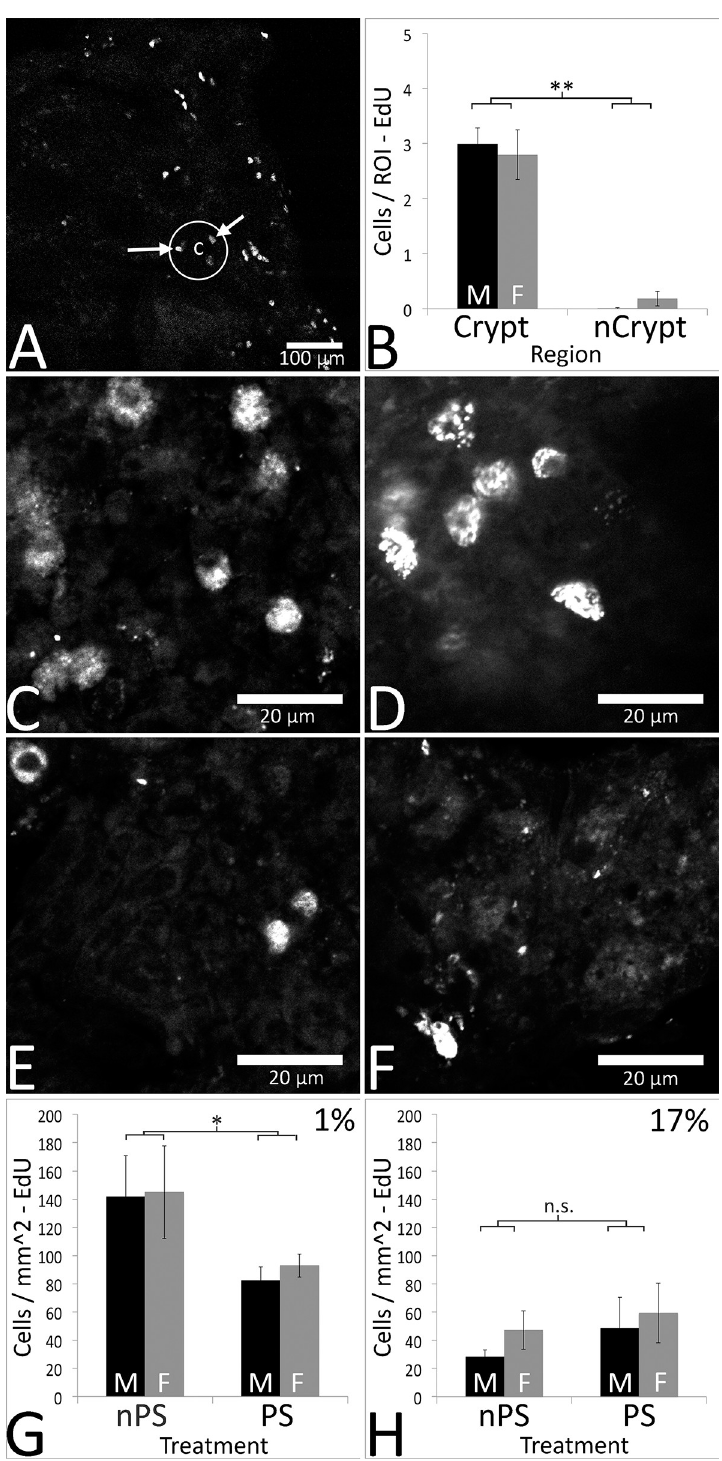
Fig 6. Incorporation of Ethynyl deoxyuridine (EdU) as indicative of DNA synthesis was observed in all oxygen and +/- PS treatments and across all time points (0 – 72h ex vivo). EdU was localized to cells in the colonic crypts (A). This localization was quantified (B), with significantly more EdU + cells per ROI observed in the crypts compared to non-Crypt (nCrypt) regions, regardless of sex (p < 0.05). Representative images of cells in slices from a male participants biopsy show increased EdU + cells in 1% nPS (C) compared to 1% PS (D), both of which are have